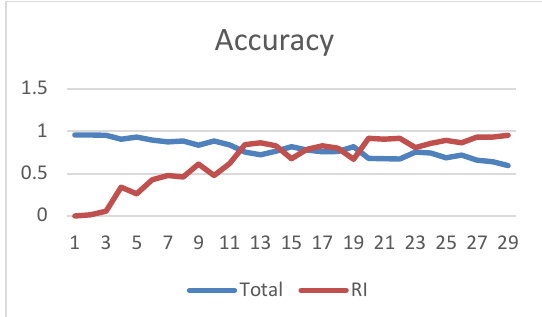
Figure 6. Accuracy of all cases and RI cases.